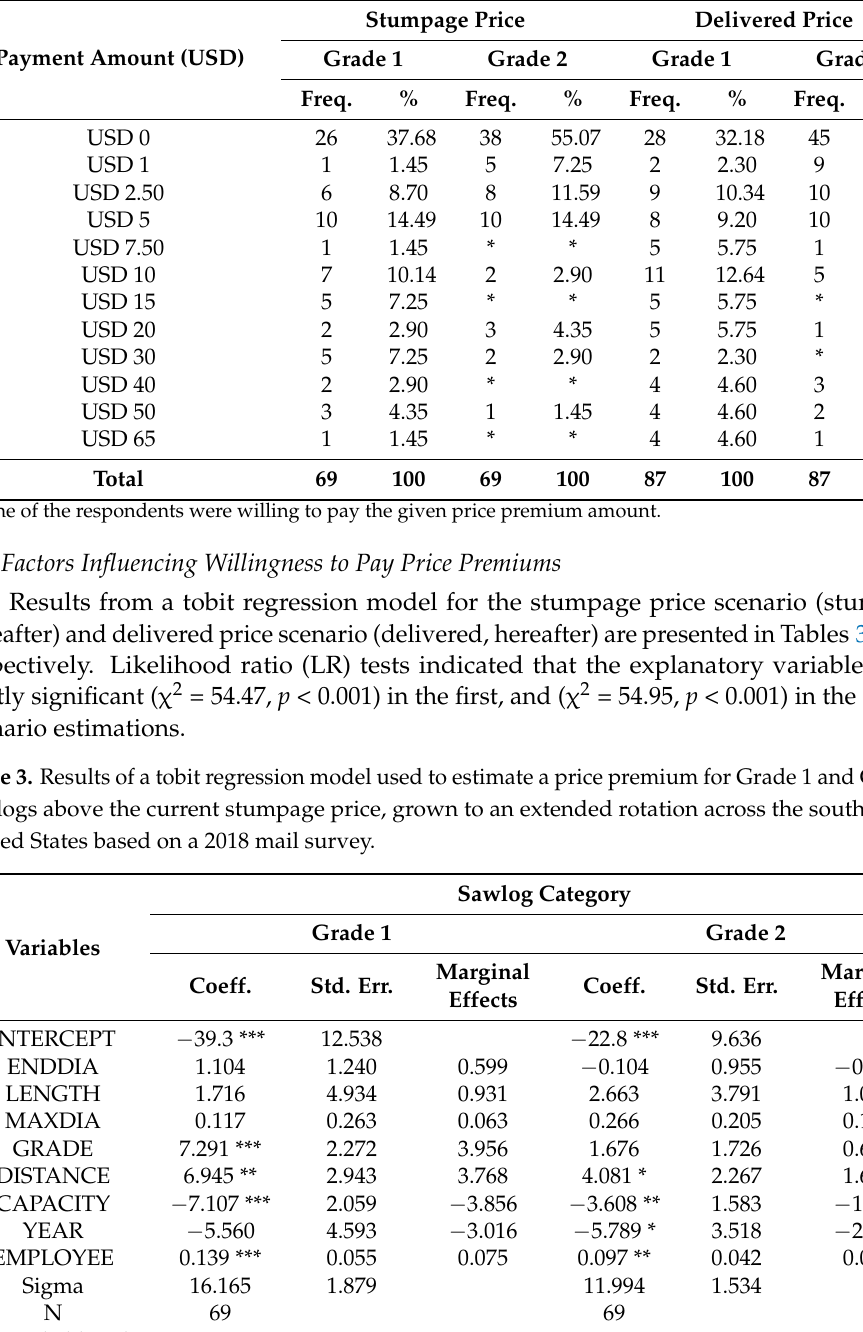
Table 2. Frequency and percentage of sawmills reporting their willingness to pay (WTP) a price premium for Grade 1 and Grade 2 sawlogs above the existing stumpage and delivered prices across the southeastern United States based on a 2018 mail survey.